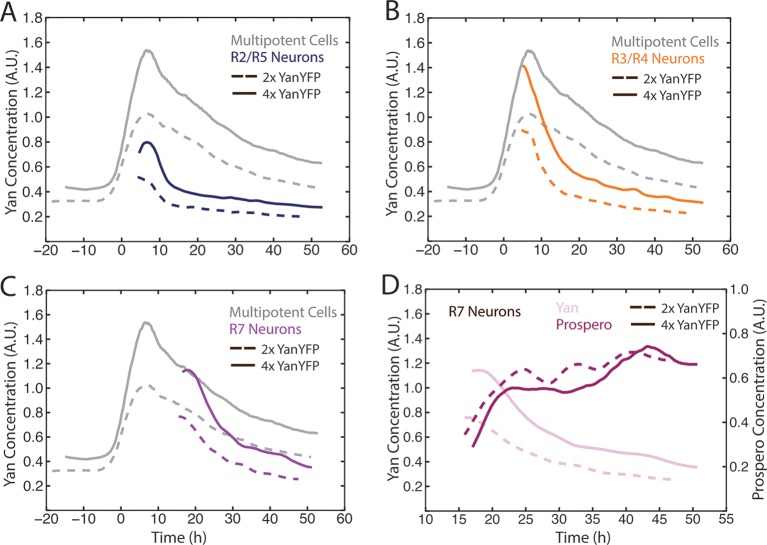
Cell state transitions are unaffected by Yan-YFP gene copy number.(A–C) Moving averages of Yan-YFP in eye discs containing two versus four copies of the Yan-YFP transgene. (A) R2/R5 and progenitor cells. (B) R3/R4 and progenitor cells. (C) R7 and progenitor cells. (D) Moving averages of Yan-YFP and Pros proteins in R7 cells containing either two vs. four copies of the Yan-YFP transgene.